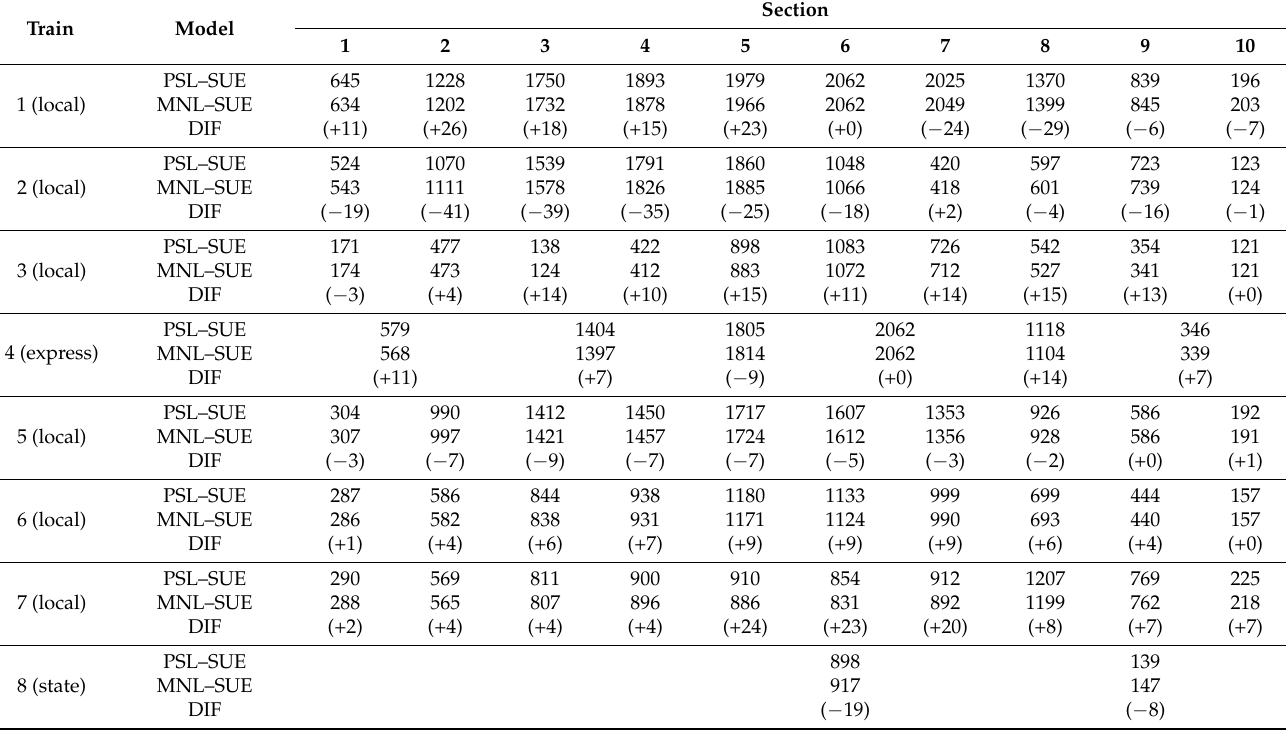
Figure 10. Passenger assignment result. Table 6. Comparison of solution results between PSL–SUE model and MNL–SUE model.